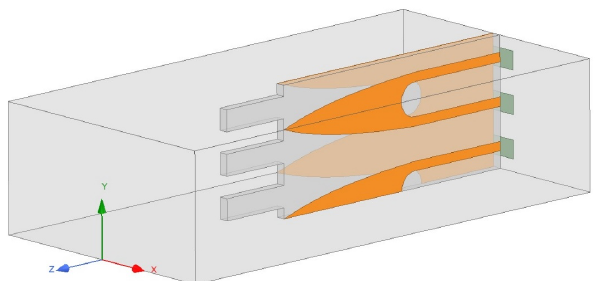
FIGURE 10. Triple Finline with NO QWT inside a WR28 Waveguide, ready for simulations.